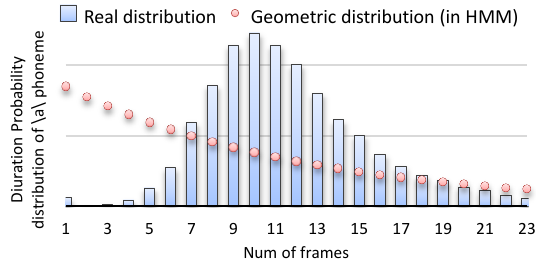
Figure 4. Duration probability distribution for vowel /a / .